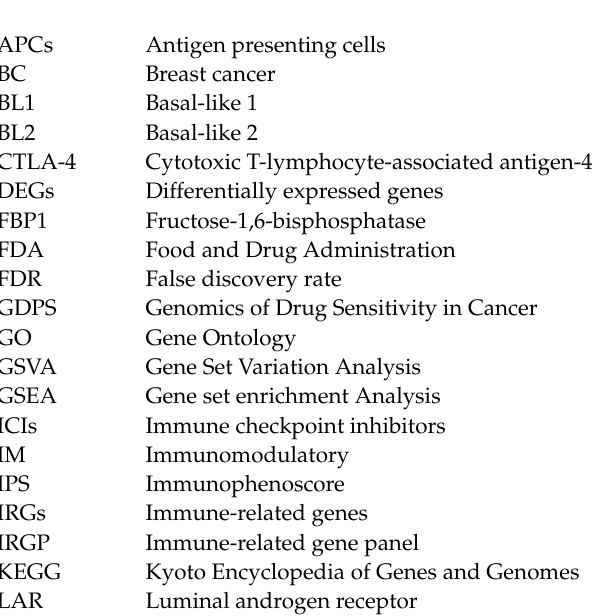
Figure S3: Network topology for different soft-thresholding powers. A soft-thresholding power of 8 was selected to achieve maximal model fit. Figure S4: Cumulative distribution function curve and relative change of delta area for identification of IRGs subtypes in TNBC. Figure S5: Functional enrichment for IRG-related genes using GO and KEGG annotation analysis. Figure S6: Analysis of tumor mutation burden associated with IRGP model. Figure S7: Analysis of drug sensitivity associated with IRGP model. Table S1: The TOP 20 terms of KEGG of DEIGs. Table S2: The TOP 20 terms of GO analysis of DEIGs. Table S3: The results of Cox regression analysis for DEGs between different IRGs